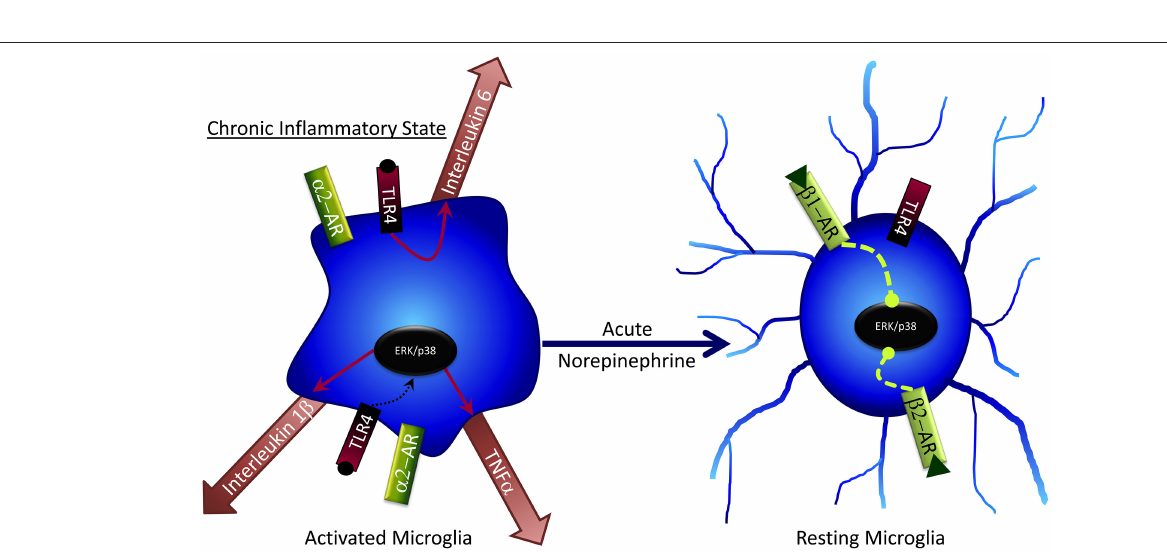
Frontiers in Integrative Neuroscience |